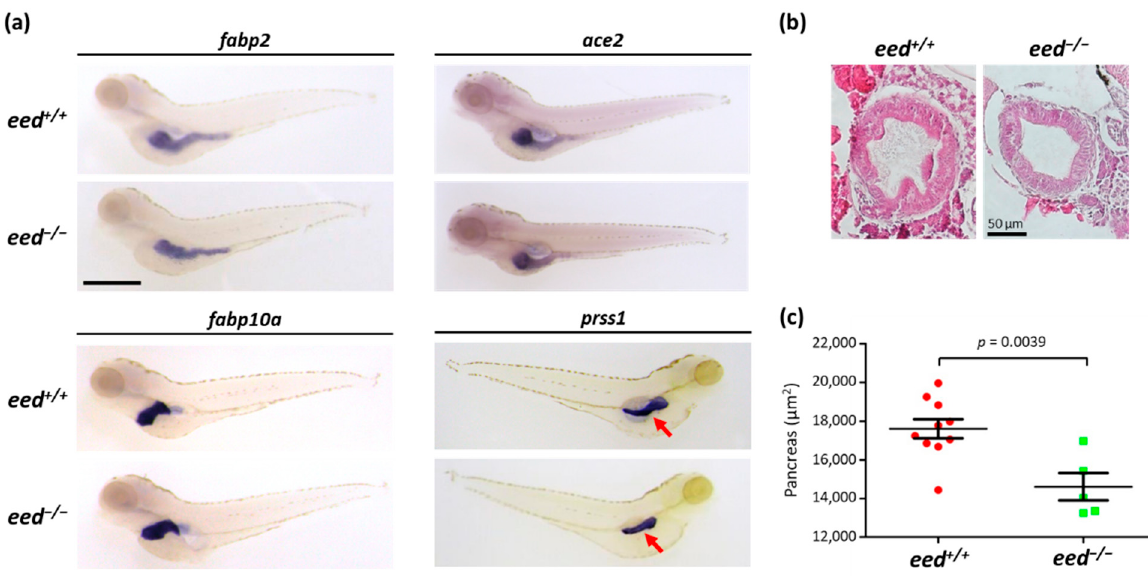
Figure 4. Organization of the digestive organs at 5 dpf: ( a ) whole-mount RNA in situ hybridization to detect the expression of markers of the intestine ( fabp2 , ace2 ), the liver ( fapb10a ), and the exocrine pancreas ( prss1 ) in eed +/+ and eed − / − siblings at 5 dpf. The red arrow shows the pancreas. Scale bar is 500 µ m; ( b ) intestinal bulb sections from eed +/+ (left) and eed − / − (right) larvae at 5 dpf stained with hematoxylin and eosin. Scale bar is 50 µ m; ( c ) measurement of the surface of the pancreas labeled by in situ hybridization using a prss1 probe at 5 dpf for eed +/+ (red) and eed − / − (green) larvae. Statistical significance was assessed by a Student t-test, and the corresponding p -value is